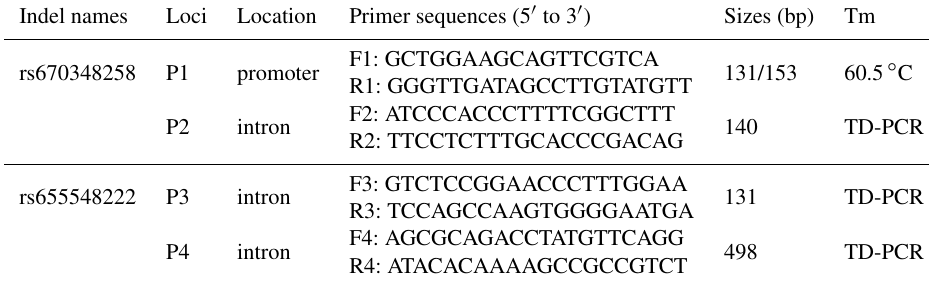
Table 1. Primers used for detecting goat PITX2 indel variants. Indel names Loci Location Primer sequences (5 (cid:48) to 3 (cid:48)